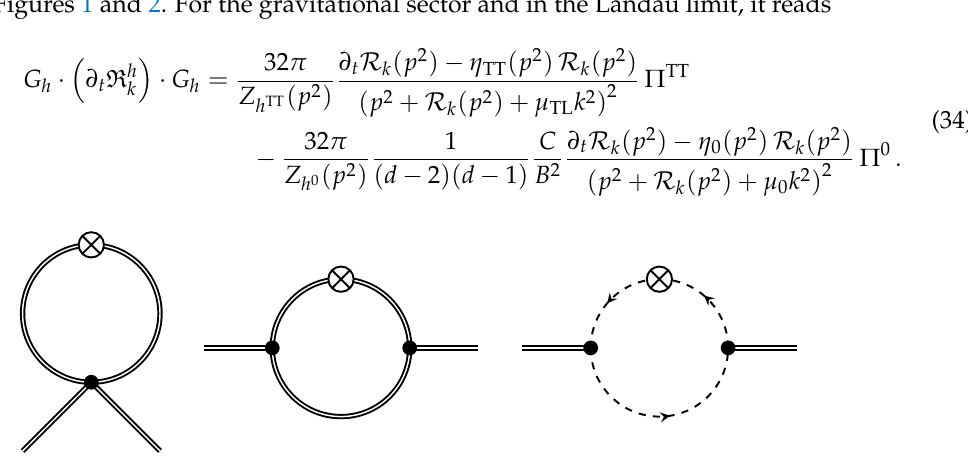
Figure 1. Diagrams that contribute to the scale dependence of the graviton two-point function. Double lines indicate gravitons, dashed lines stand for the Faddeev–Popov ghosts, and the circled cross denotes the regulator insertion ∂ t R k